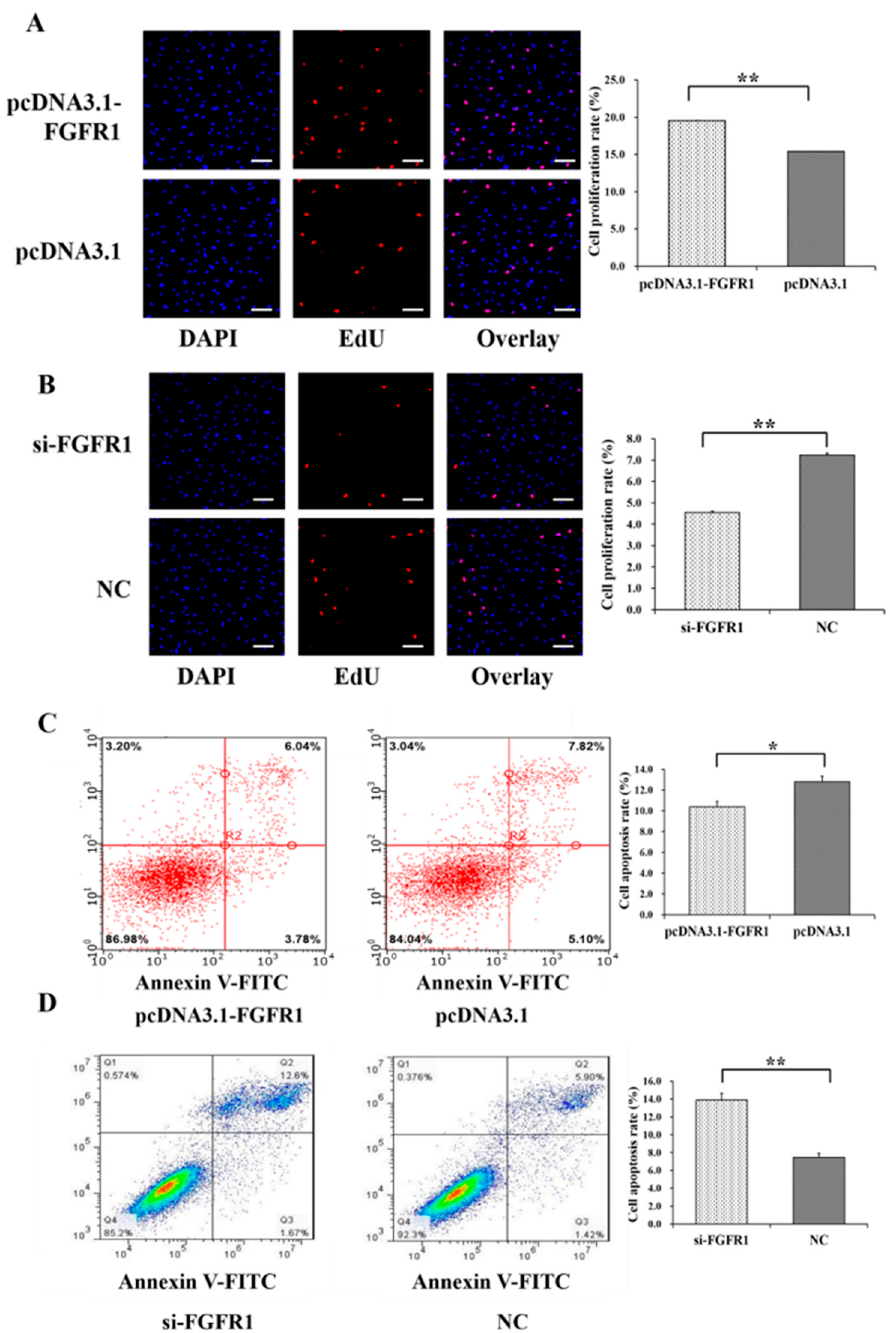
Figure 6. Biological e ff ects of FGFR1 on cell proliferation and apoptosis of GCs. The cell proliferation rate of GCs after treatment by pcDNA3.1-FGFR1 ( A ) and si-FGFR1 ( B ). The cell apoptosis rate of GCs after treatment by pcDNA3.1-FGFR1 ( C ) and si-FGFR1 ( D ). * indicates p < 0.05; ** indicates p < 0.01. Data are represented as means ± SD. The scale bar represents 100 µ m. NC: negative control; PcDNA3.1-FGFR1: pcDNA3.1 overexpression plasmid of FGFR1 ; Si-FGFR1: specific siRNA for FGFR1 .